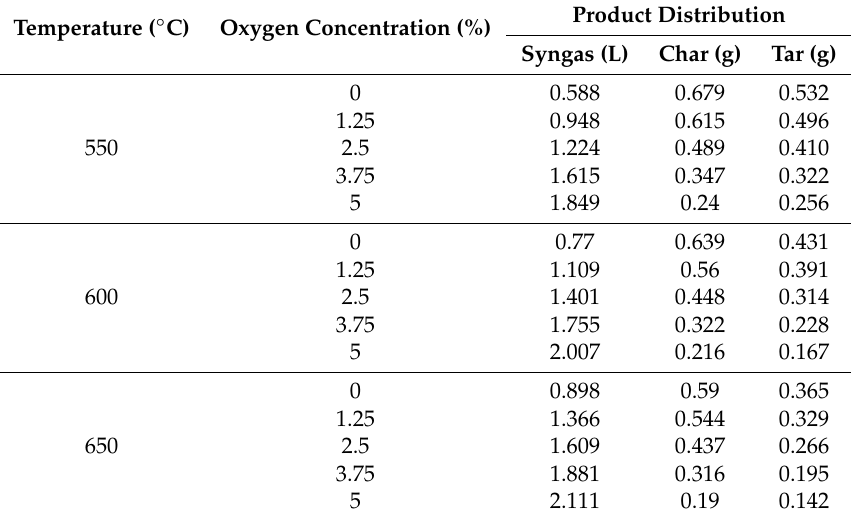
Table 1. Gasification operating conditions and product distribution.